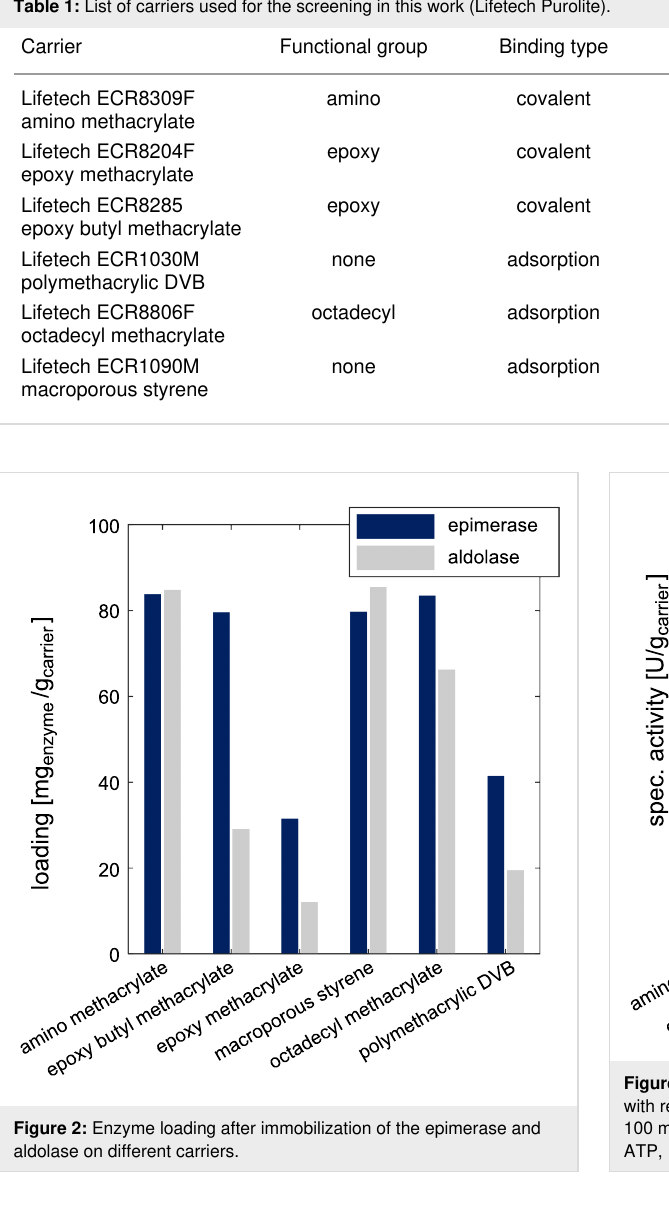
aldolase showed a lower yield of 70 mg enzyme /g carrier (octadecyl methacrylate) and between 10–30 mg enzyme /g carrier for the other evaluated carriers.